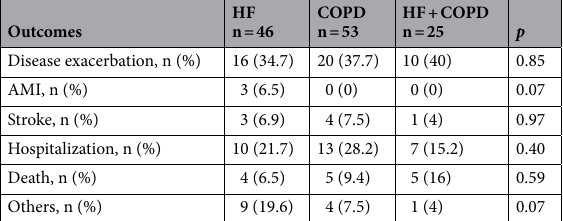
Table 3. Occurrence of cardiopulmonary events during the follow-up period. AMI acute myocardial infarction, Others gastric or renal or intestinal surgery, decompensation of non-cardiopulmonary diseases.